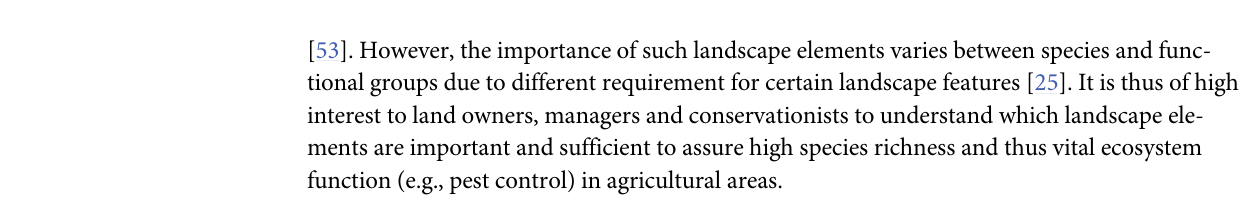
Fig 2. Bat activity on 50 grassland plots in relation to forest extent in the 200m buffer zone throughout five sampling months. n.s = non significant, P < 0.05 * , P < 0.001 = ***